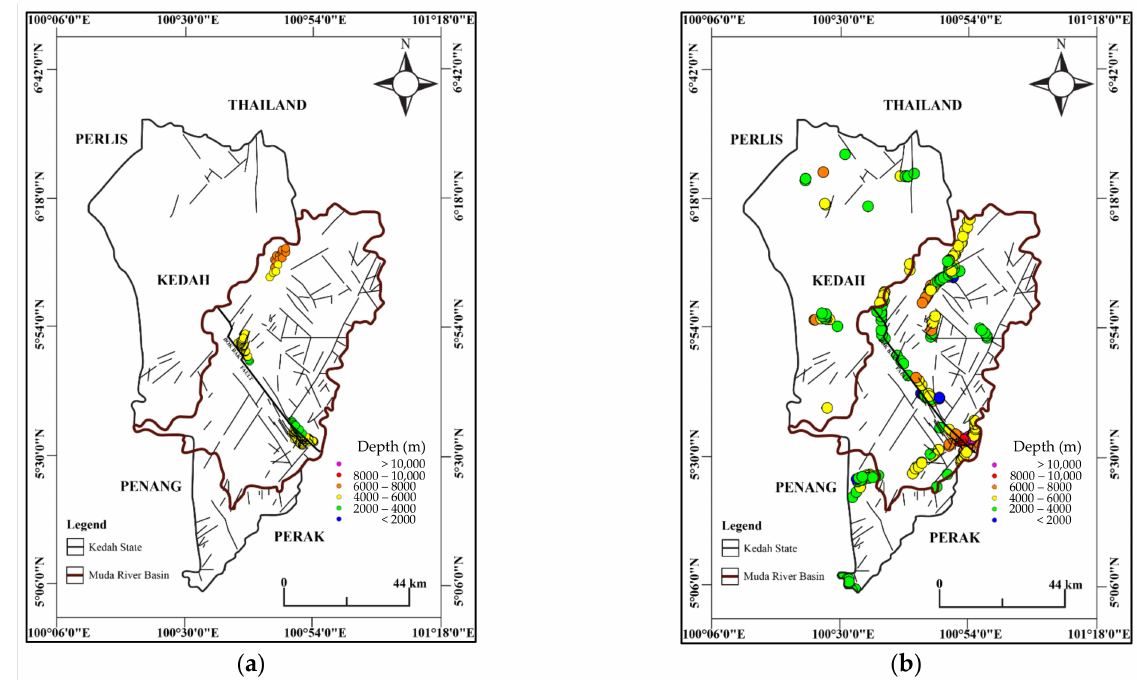
Figure 9. Two Euler solutions of the Bouguer anomaly map of structural index = 0.0, with a window size of ( a ) 20 km × 20 km; ( b ) 5 km × 5